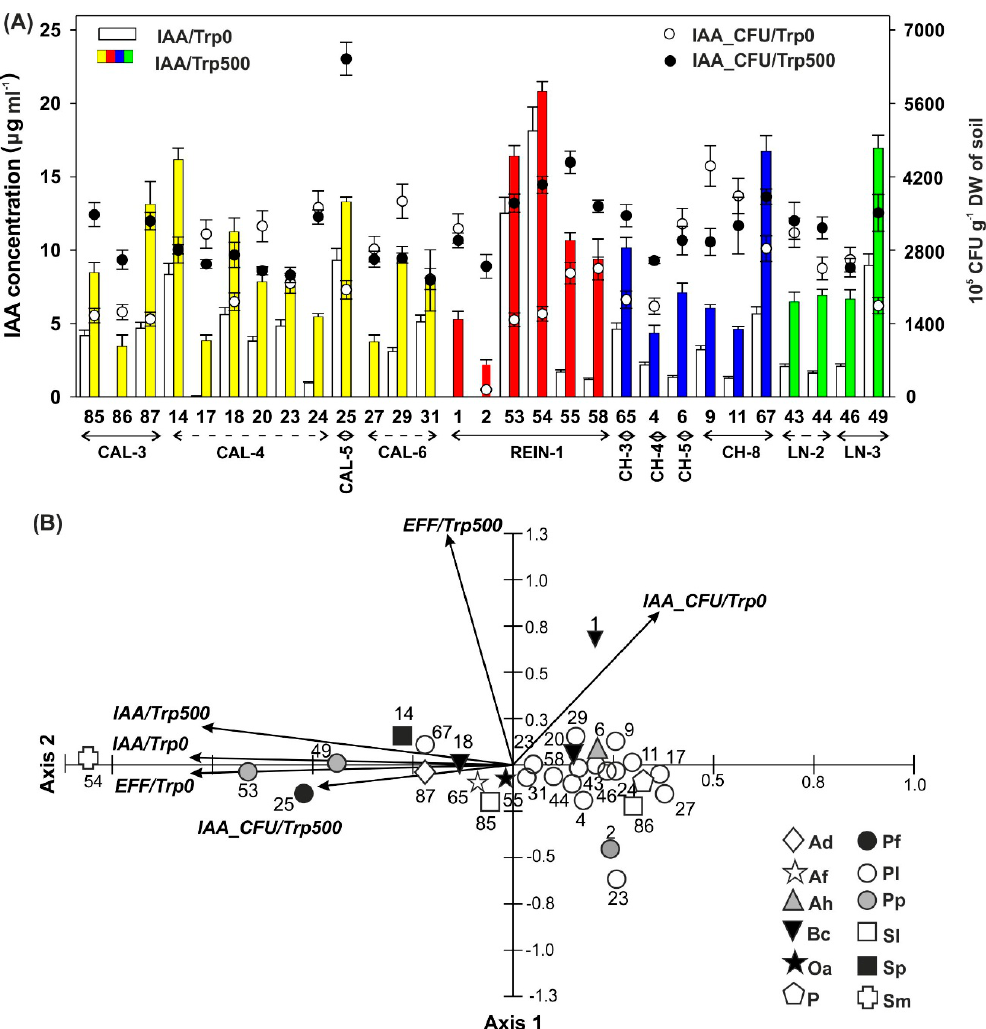
Figure 7. IAA (indole-3-acetic acid) concentration; Trp0 = without tryptophan (Trp); Trp500 =